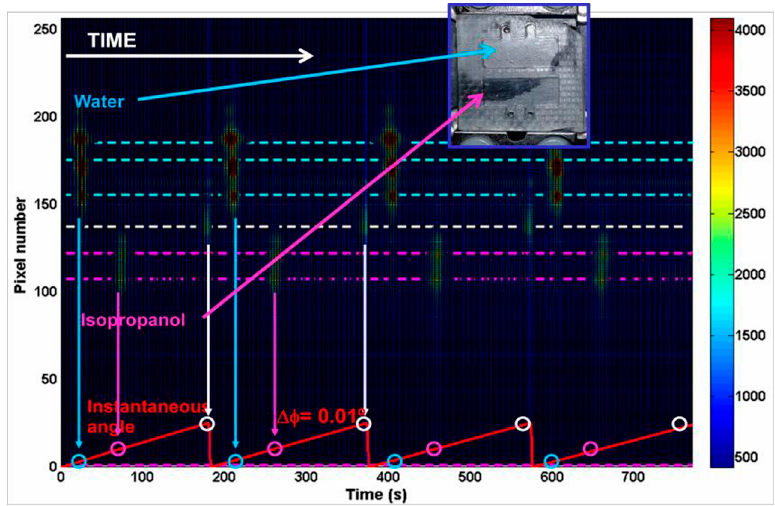
Figure 4. Coupling for water and isopropanol: pixel intensity and angle (red line) vs.